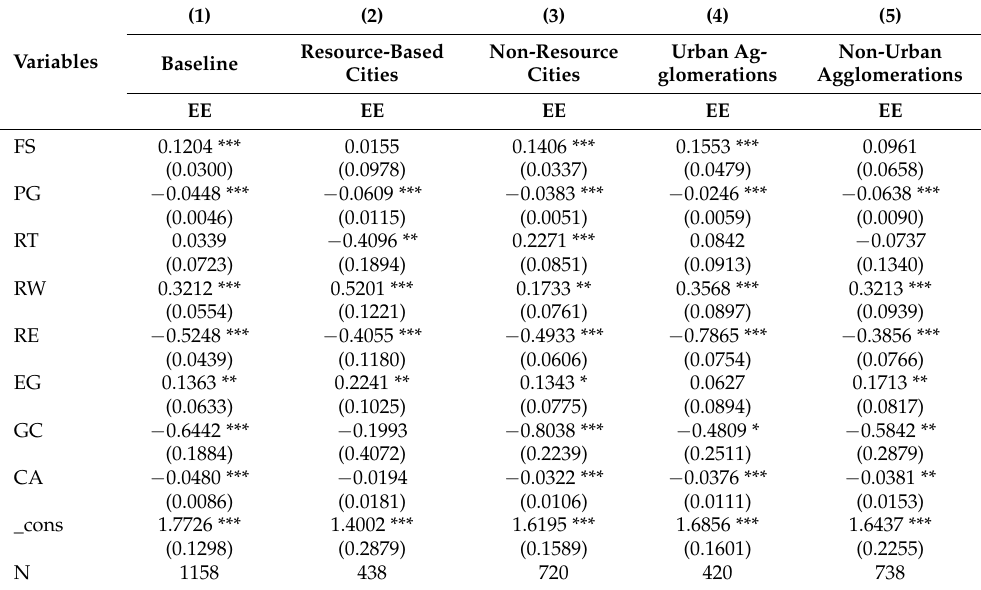
Table 9. Empirical analysis of urban characteristic heterogeneity